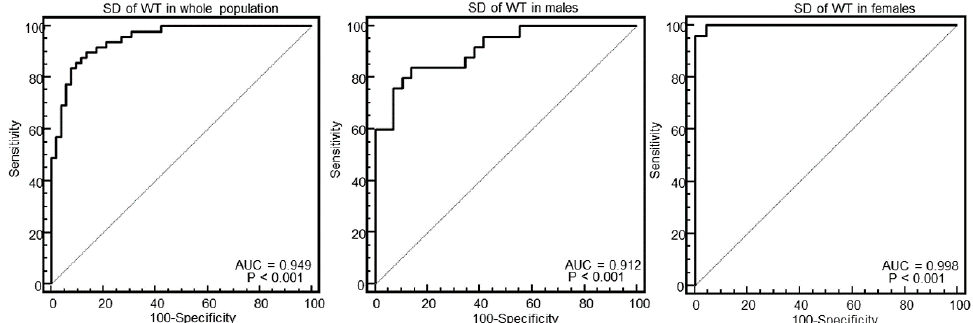
Figure 6. Receiver operating characteristic curves of the standard deviation of wall thickness (WT) for identification of patients with HCM in the whole population, and in males and females.